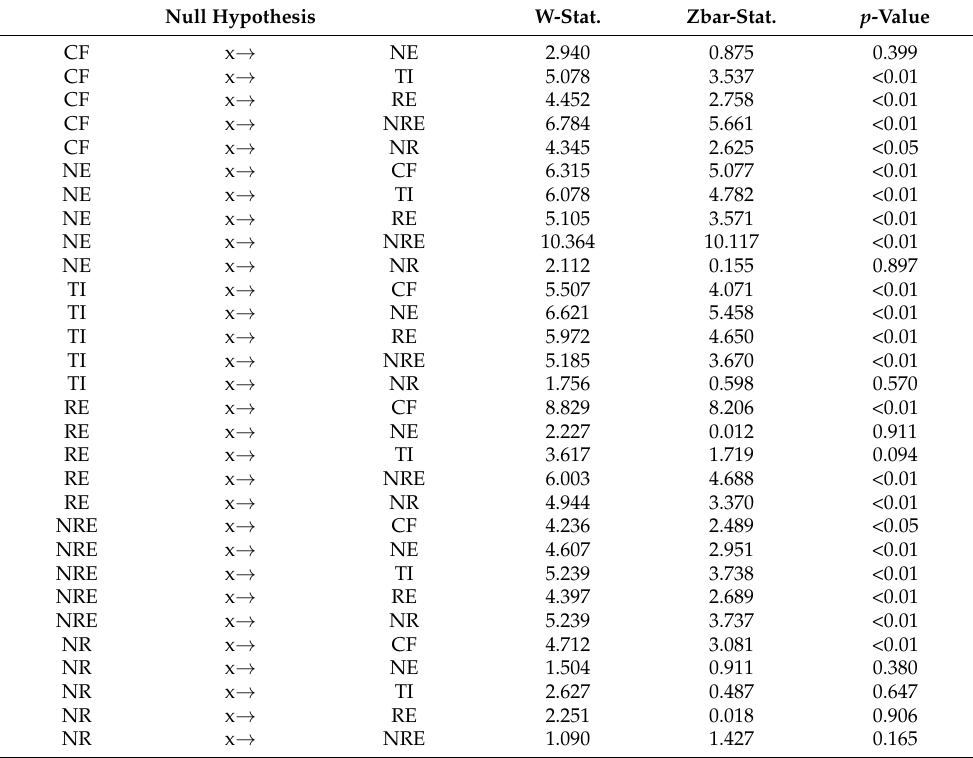
Table 8. Dumitrescu and Hurlin Causality